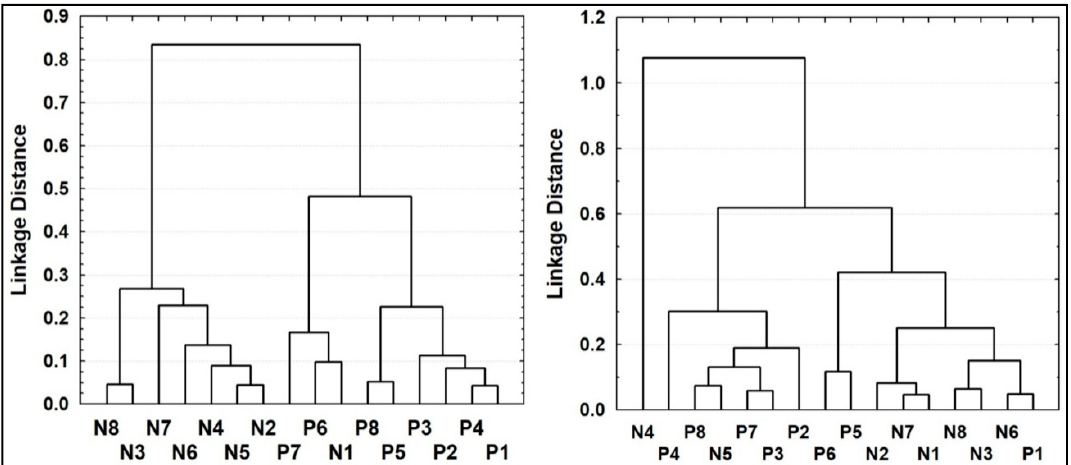
Figure 4. Cluster analysis for crown traits in the M ă neciu ( left ) and Soveja ( right ) trials. Diagram for crown traits, complete linkage, Euclidean distances.